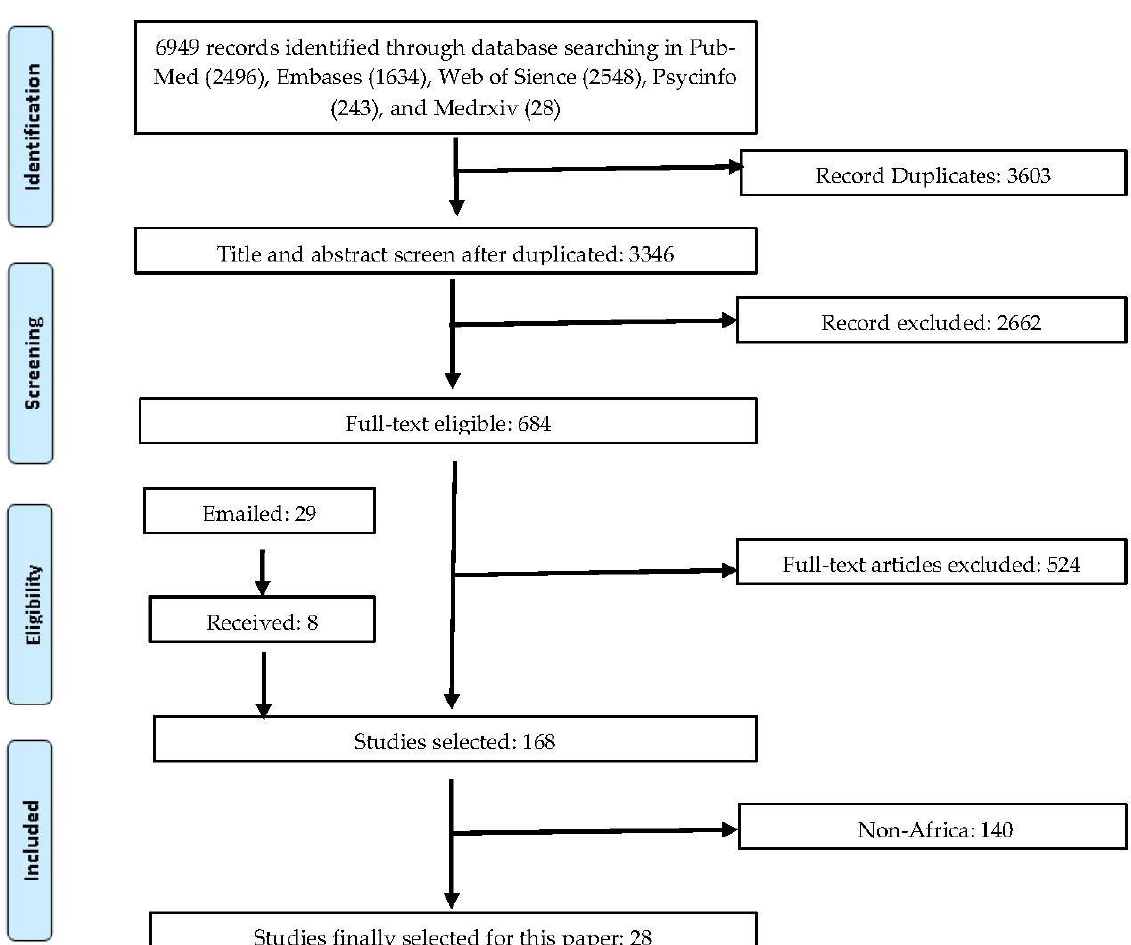
Figure 1. A PRISMA flow diagram.